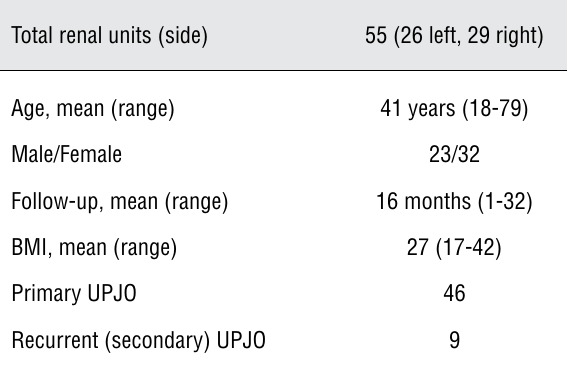
Table 1 - Patient